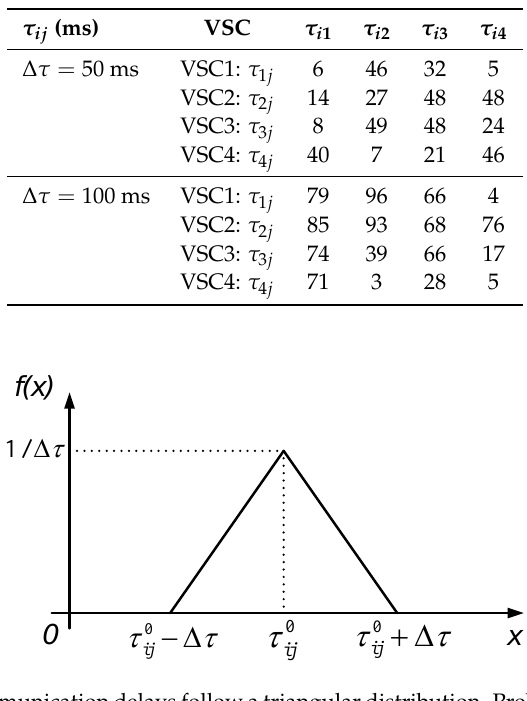
Figure 19. Case D: Communication delays follow a triangular distribution. Probability density function.